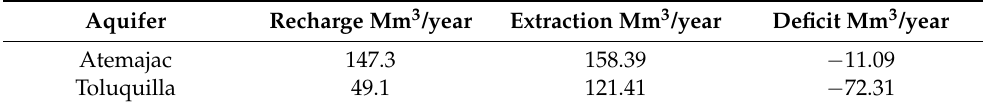
Table 3. Situation of Aquifers in the